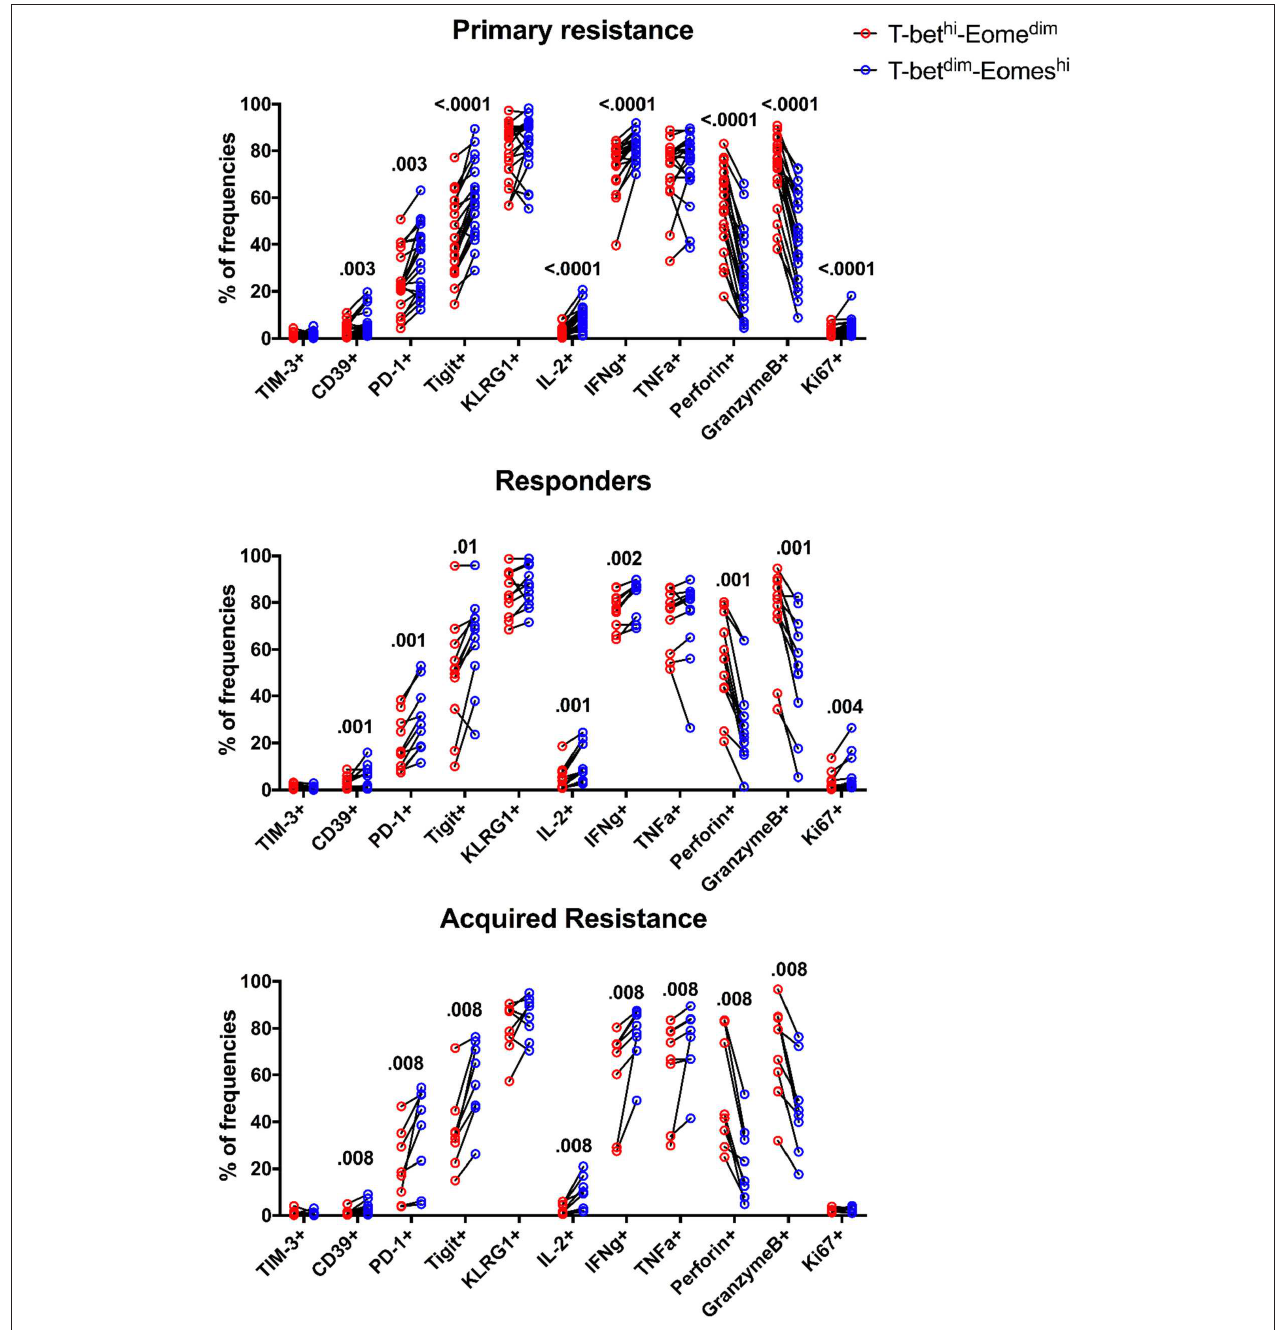
FIGURE 6 | Expression patterns of inhibitory receptors and cytokines on different subsets of CD8T cells. The frequency of TIM-3, CD39, PD-1, TIGIT, KLRG1, IL-2, IFN γ , TNF α , Perforin, GranzymeB, and Ki-67 expressing cells within total T-bet dim Eomes hi (blue) and T-bet hi Eomes dim (red) CD8T cells for all baseline samples. Statistical analysis was performed with a Wilcoxon matched-pairs single rank